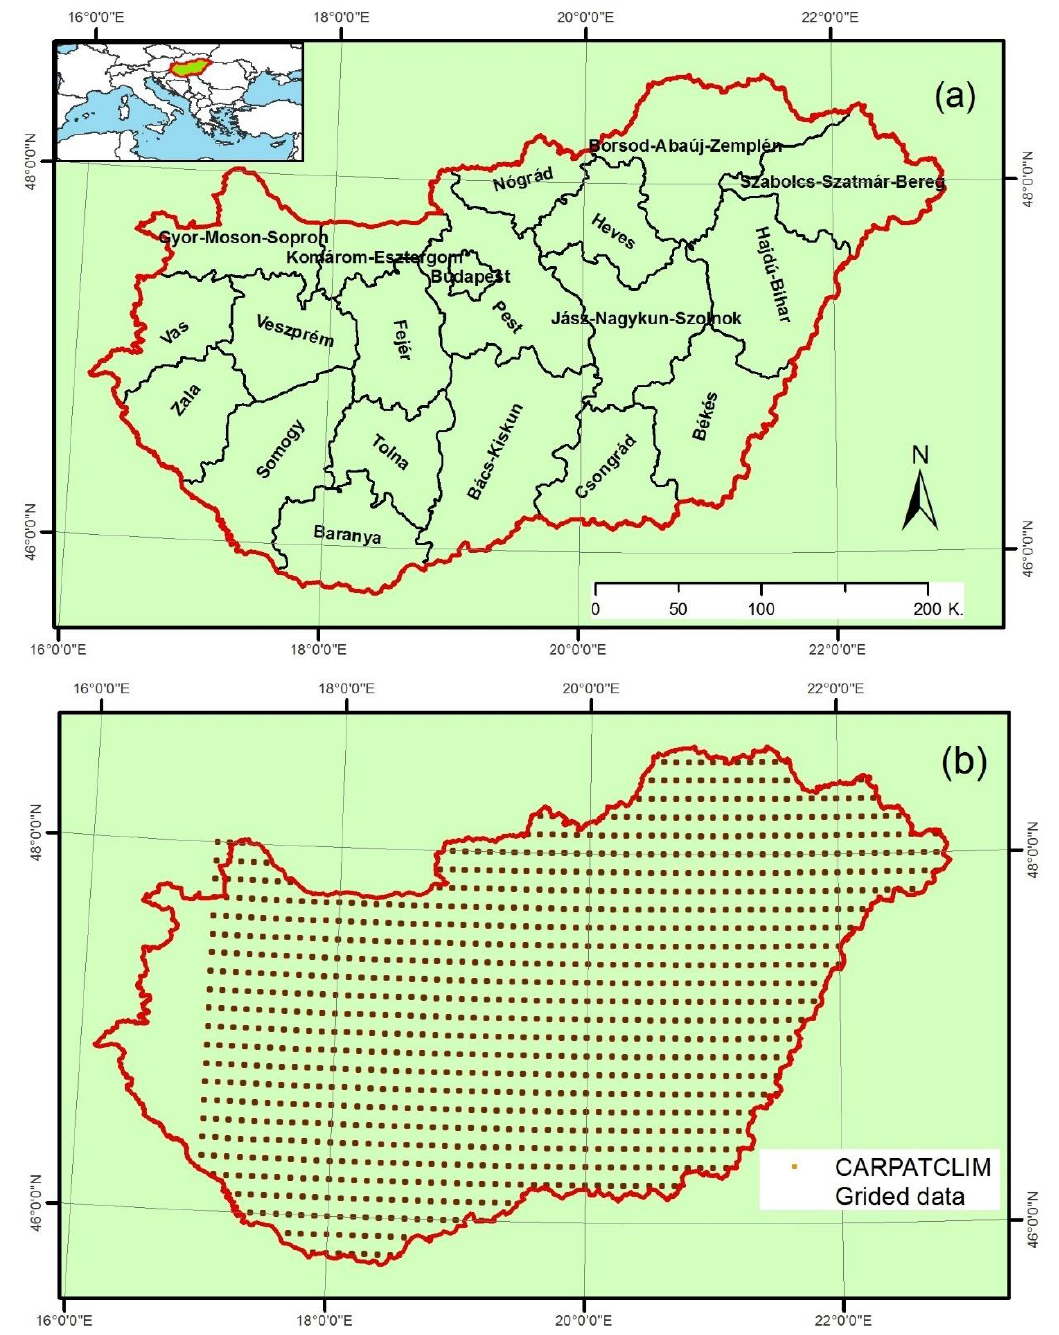
Figure 1. Map of Hungary: ( a ) Hungarian counties, and ( b ) distribution of 1045 gridded points across